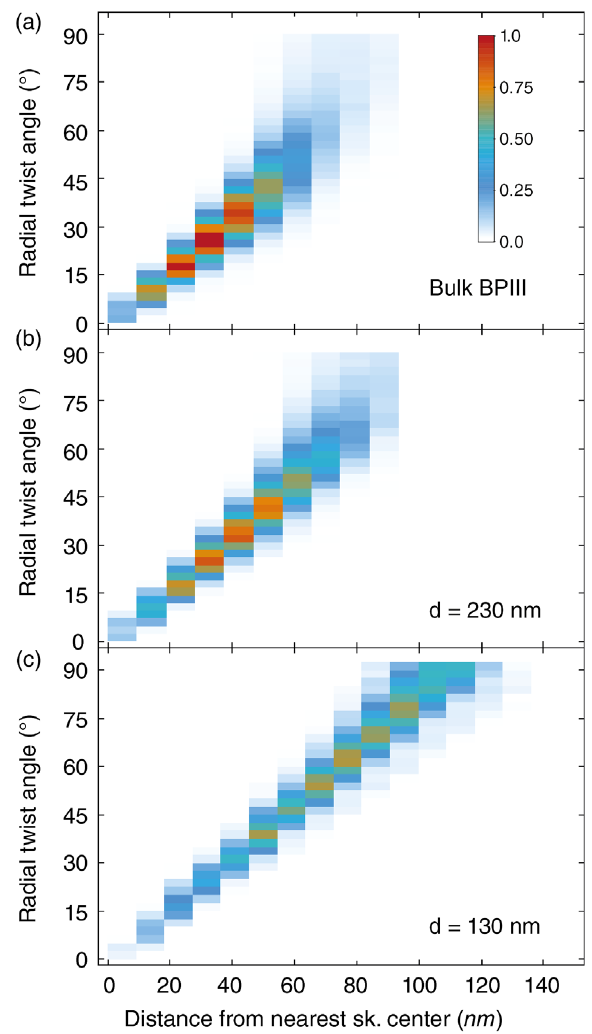
FIG. 11. Radial director twist angle distribution in thin, thick, and bulk BPIII. (a) The distribution of radial director twist for all voxels as a function of the distance from the skyrmion center, calculated for bulk BPIII in Fig. 10(c). (b) The distribution of radial director twist for all voxels as a function of the distance from the skyrmion center, calculated for 230-nm-thick BPIII in Fig. 10(b). (c) The distribution of radial director twist for all voxels as a function of the distance from the skyrmion center, calculated for 130-nm-thin BPIII in Fig. 10(a).